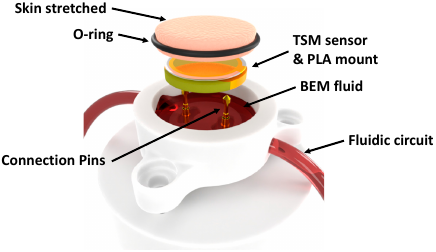
Figure 1. Magnified view of the fluidic system integrating the TSM transducer coupled with an ex vivo skin explant and the culture medium (air-liquid interface culture conditions).